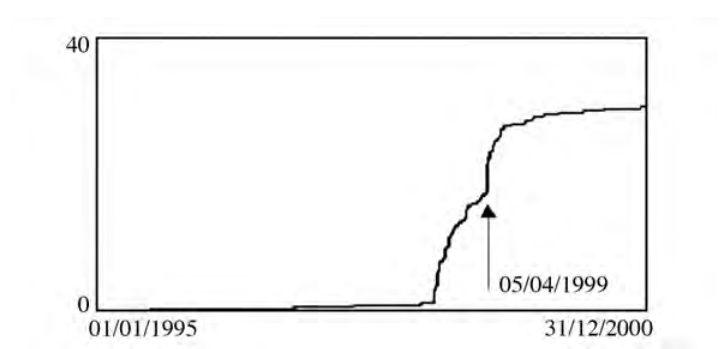
Fig. 14. Cumulative moment release (dyne·cm ∗ 10 20 ) in the investigated area as resulting by considering all the events with the exclusion of the main shock. m d values have been converted to moment applying the relation by Selvaggi et al. (1997). Arrow marks the starting date of the last phase of the seismic sequence.